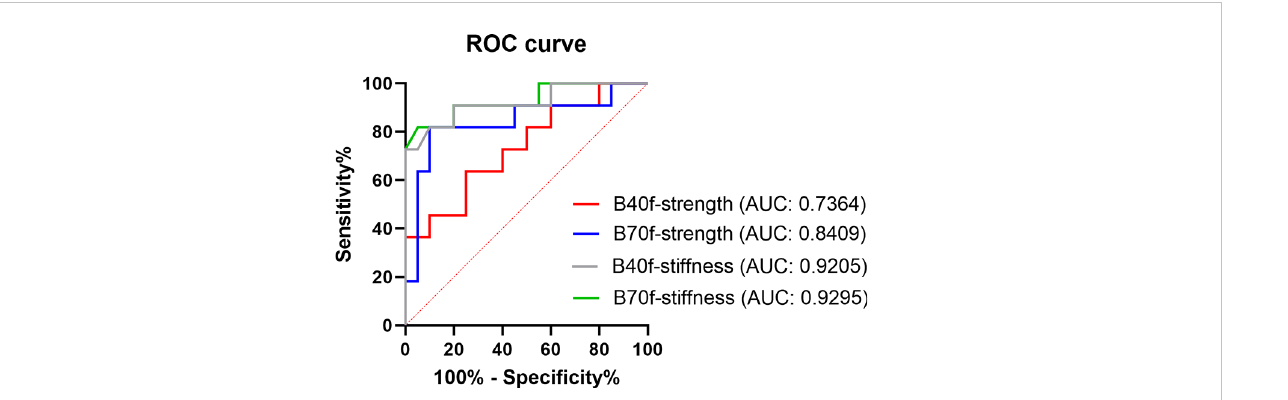
FIGURE 4 ROC curve showing the ef fi cacy in distinguishing osteoporosis from the normal bone mass of FE-estimated strength and stiffness based on smooth standard kernel (B40f) and sharp bone kernel (B70f)